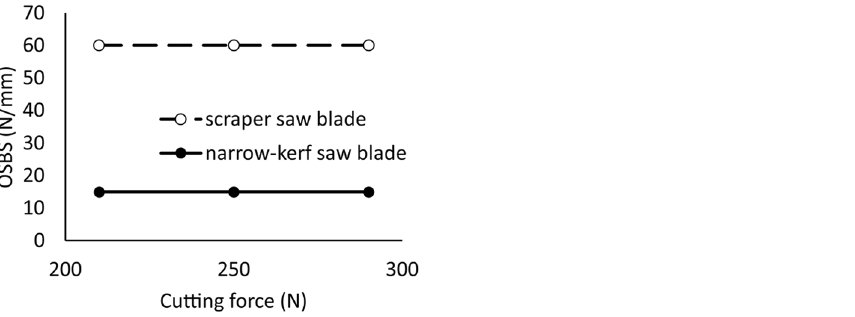
Figure 9. The operational saw blade stiffness OSBS of the narrow-kerf and scraper saw blades as a function of the cutting force (calculations for F p = 100 N and F f = 125 N).